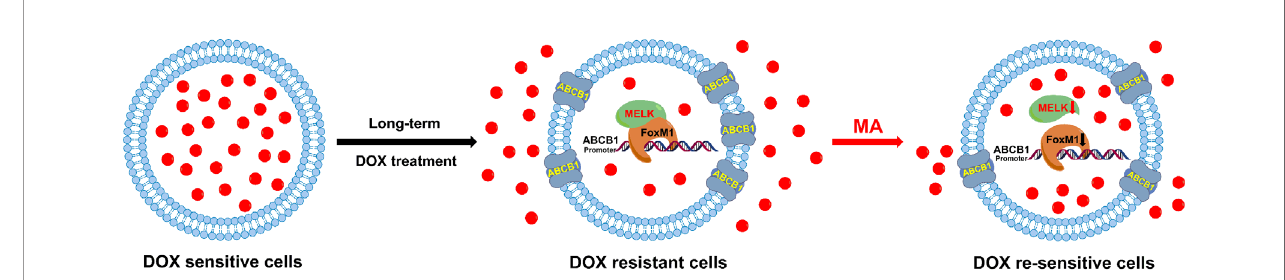
FIGURE 9 | Diagram of the proposed mechanism of MA on DOX response in MDA-MB-231/DOC